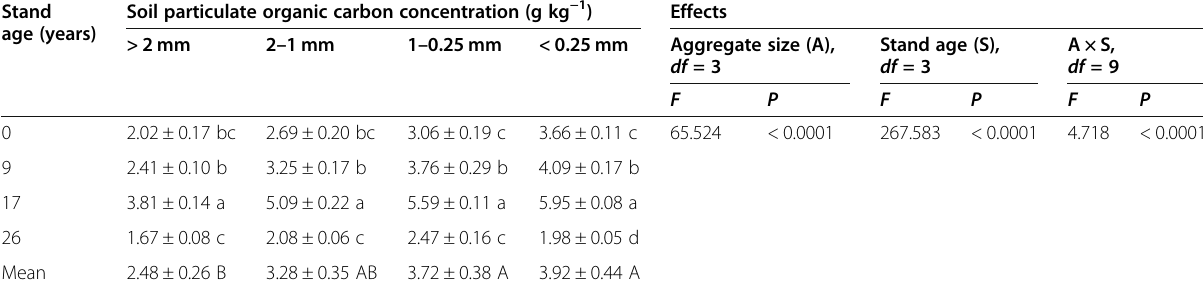
Table 5 Effects of aggregate sizes (> 2, 2 – 1, 1 – 0.25, and < 0.25 mm) and stand ages (0, 9, 17, and 26 years) on the soil particulate organic carbon concentration in a chronosequence of Chinese fir plantations Stand Soil particulate organic carbon concentration (g kg − 1 age (years)